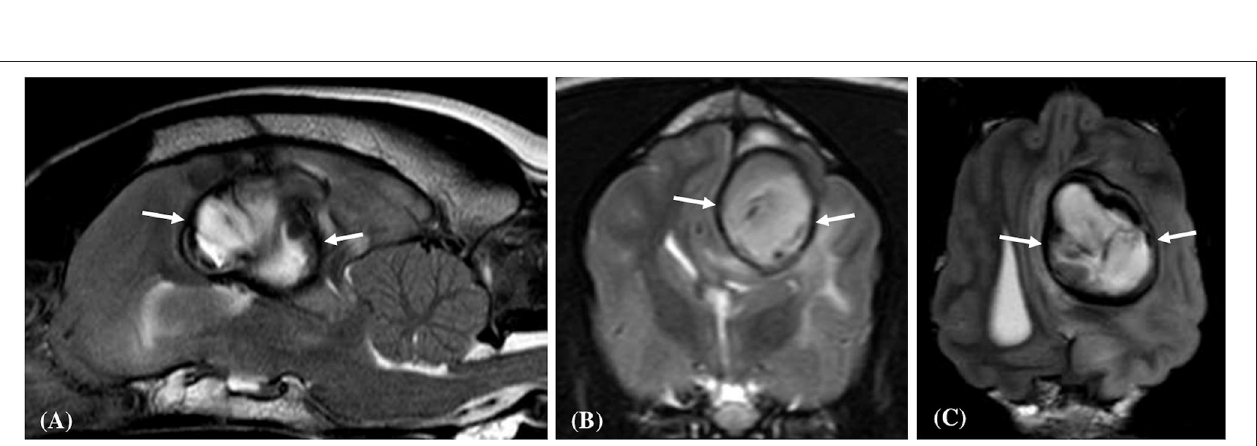
FIGURE 3 | Left parasagittal (A) , transverse (B) , and dorsal (C) plane T2- weighted images of a dog (Case 8) with a large well-defined intracranial intra-axial hematoma affecting the white matter of the left parietal lobe. Note the circumferential nature of the thin hypointense rim (white arrows) in all three planes. Additionally, the lesion induces a marked mass effect resulting in transtentorial herniation, subfalcine herniation and compression of the left lateral